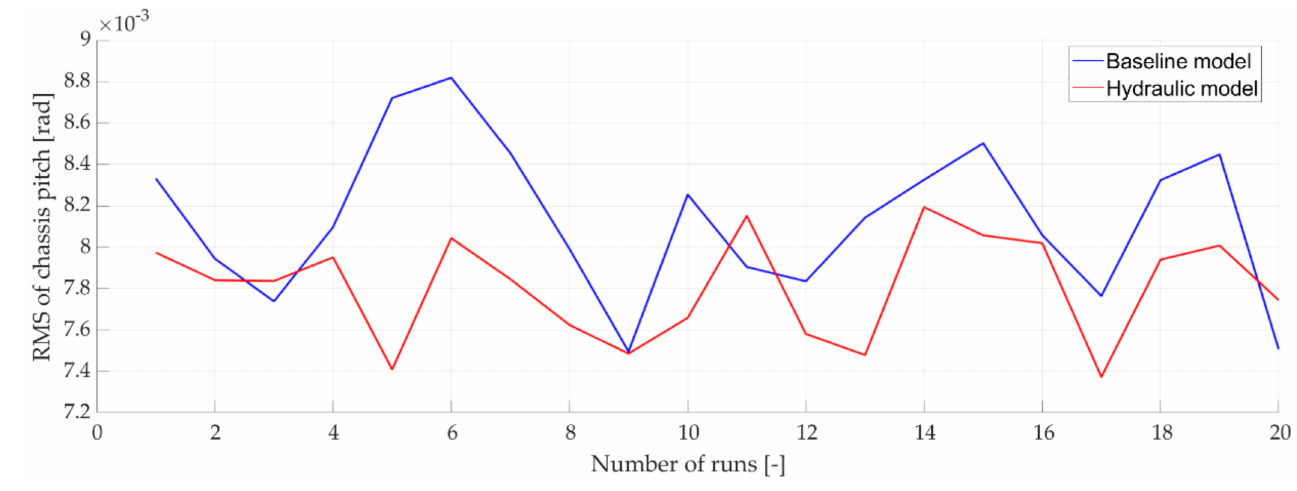
Figure 29. Chassis pitch root mean square for a realistic road profile and external